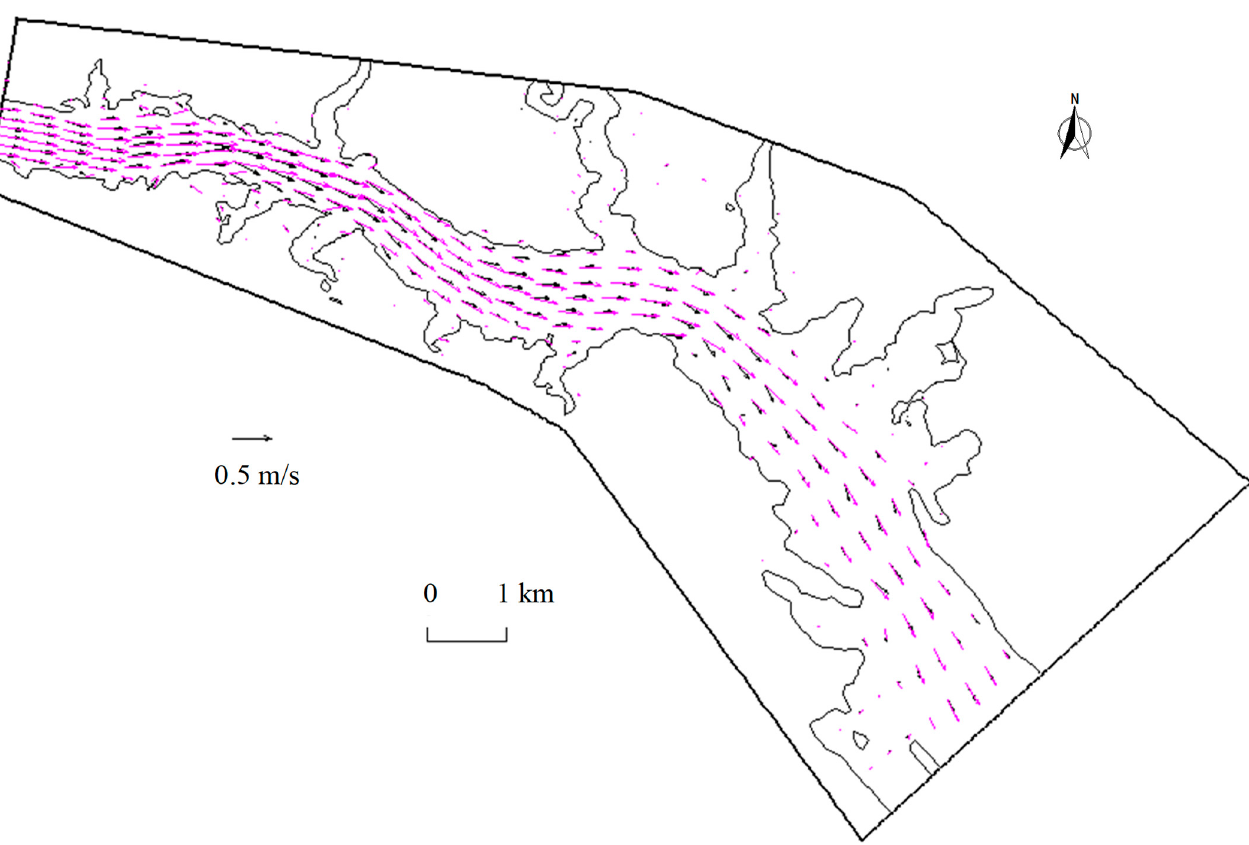
Figure 7. Calculated velocity fields near the bottom and the water surface (the blue lines are the velocity vectors close to the water surface, and the black lines are the vectors close to the bottom).